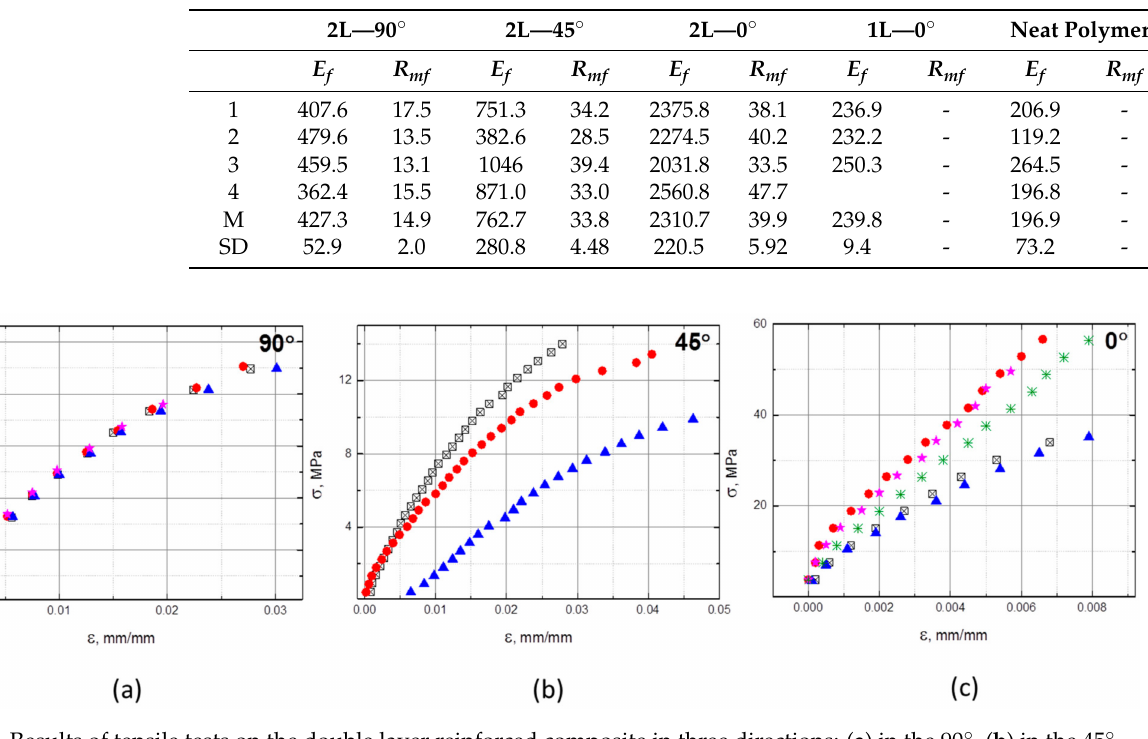
Figure 4. Results of tensile tests on the double layer reinforced composite in three directions: ( a ) in the 90 ◦ , ( b ) in the 45 ◦ direction and ( c ) in the 0 ◦ direction, with respect to UD fibers orientation (a data set for each tested specimen is presented with a different